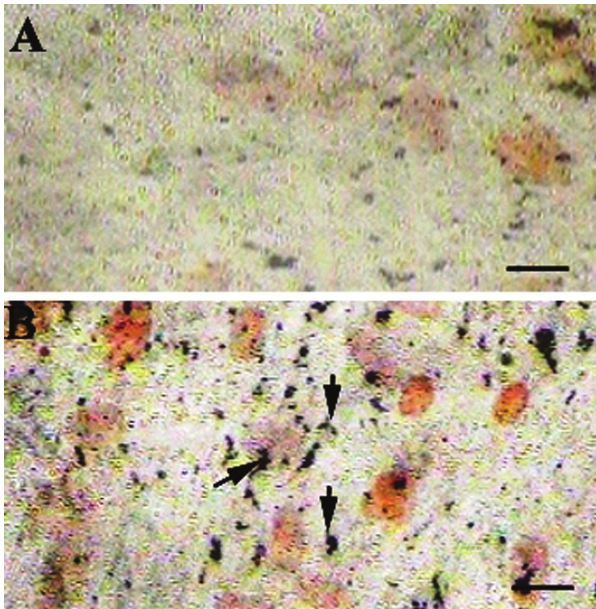
Figure 4 - CQ treatment induces extracellular matrix mineralization: Undif- ferentiated MSCs grown in basal media did not display deposition of calcium salt in the extracellular matrix (A) even after 28 days of culture. Treating undifferentiated MSCs with 300 µg/mL CQ extract promoted mild deposition of calcium after 15 days of treatment. Scale bar = 50 µm